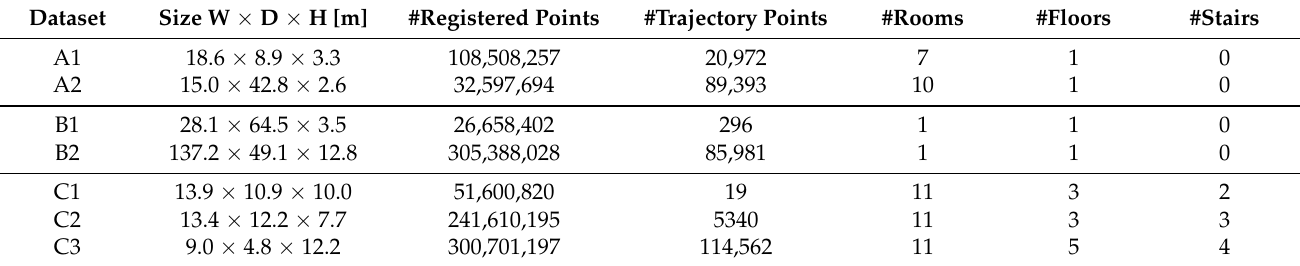
Table 2. Environment of indoor spaces used in the